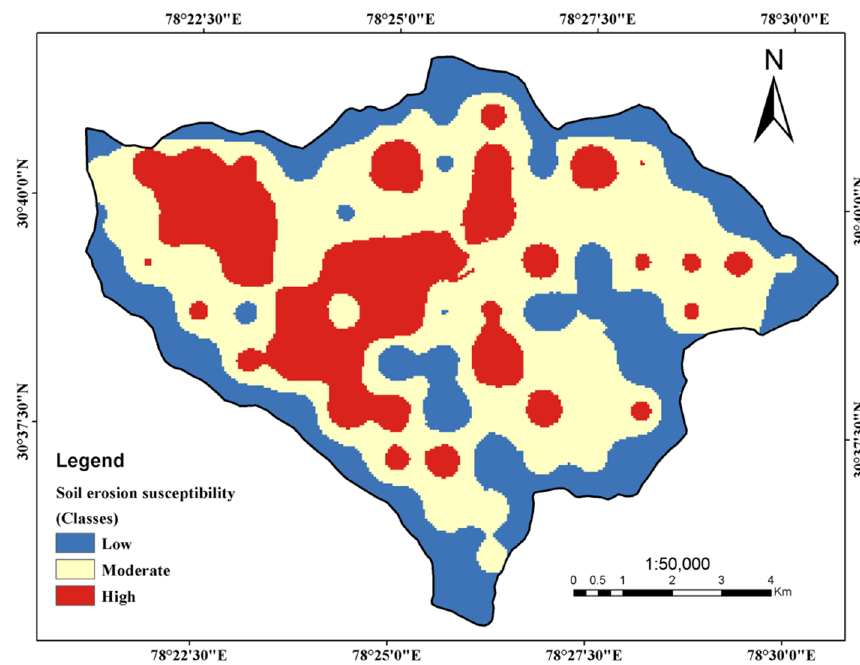
Fig. 6 Soil erosion and flood vulnerability map of Dhanari